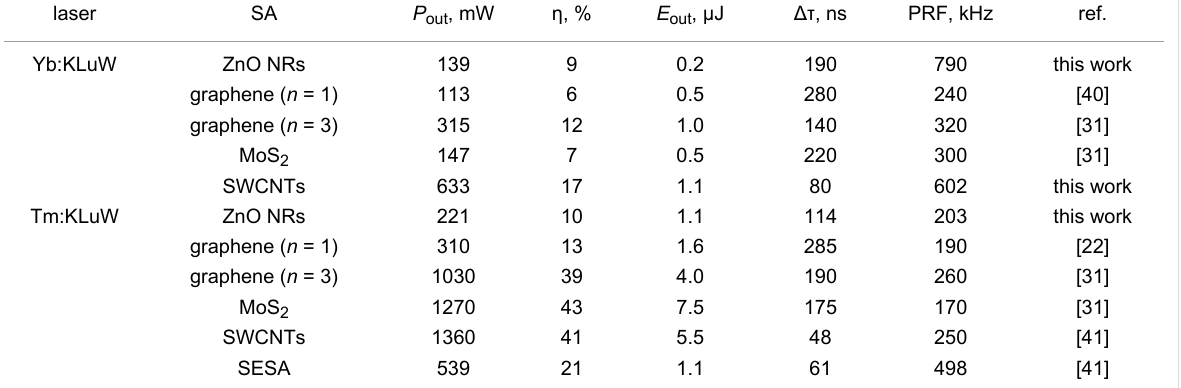
Table 3: Output characteristics of compact Yb:KLuW and Tm:KLuW lasers passively Q-switched by different “fast” saturable absorbers (SAs).